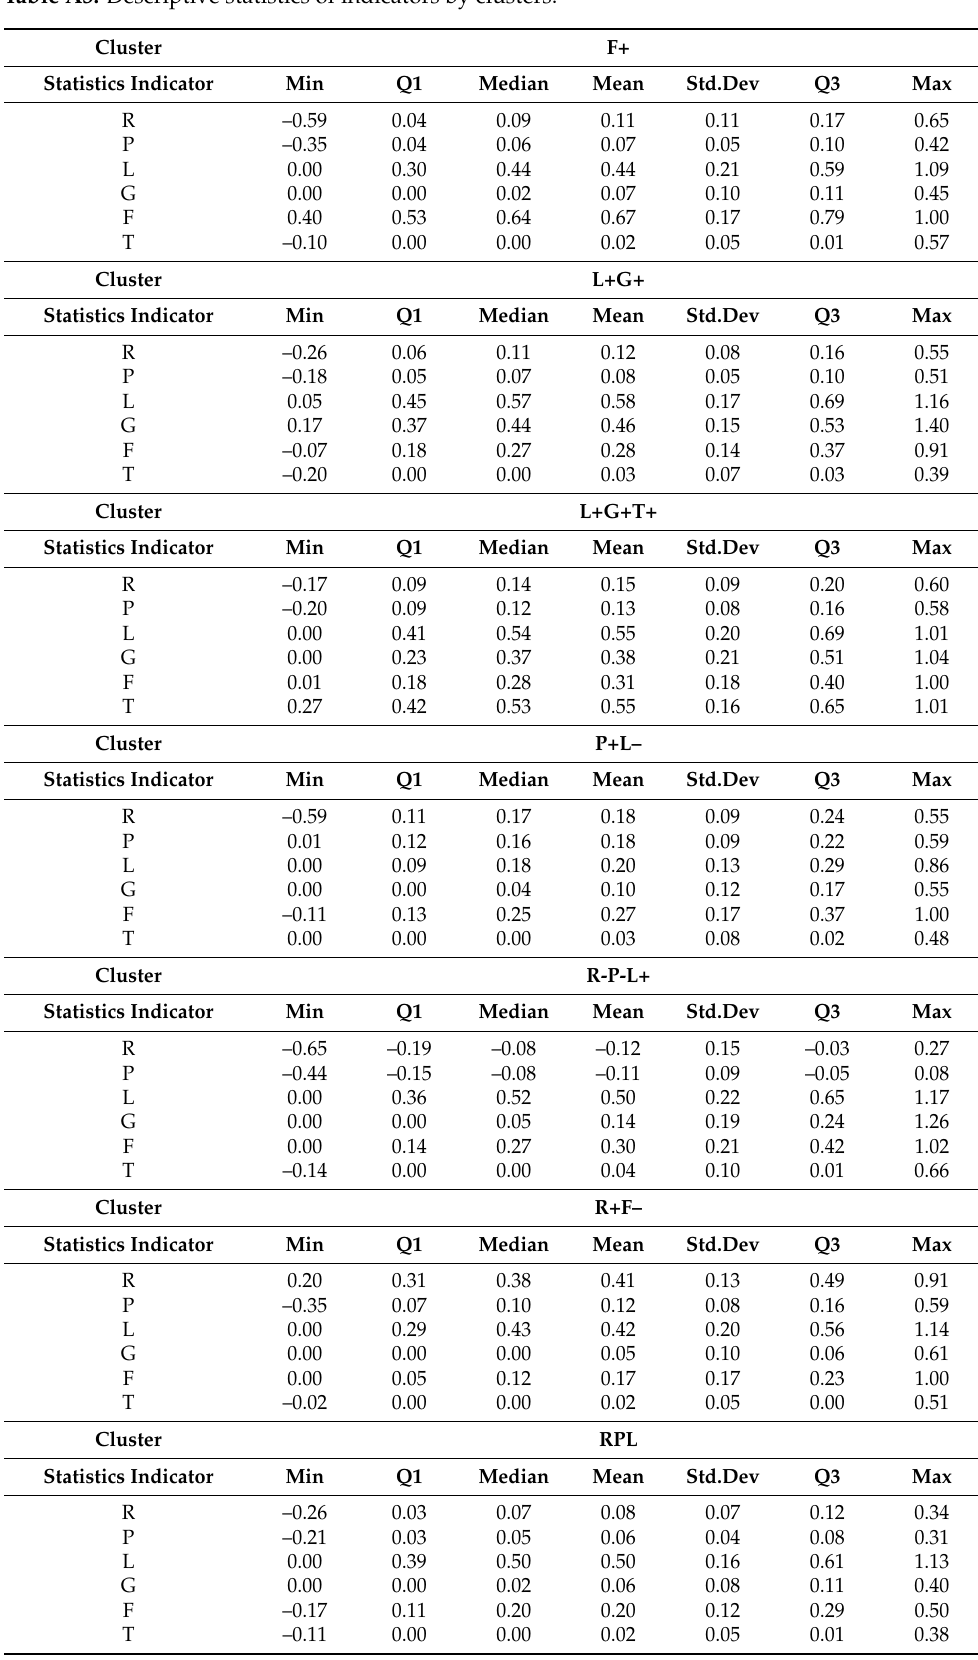
Table A3. Descriptive statistics of indicators by